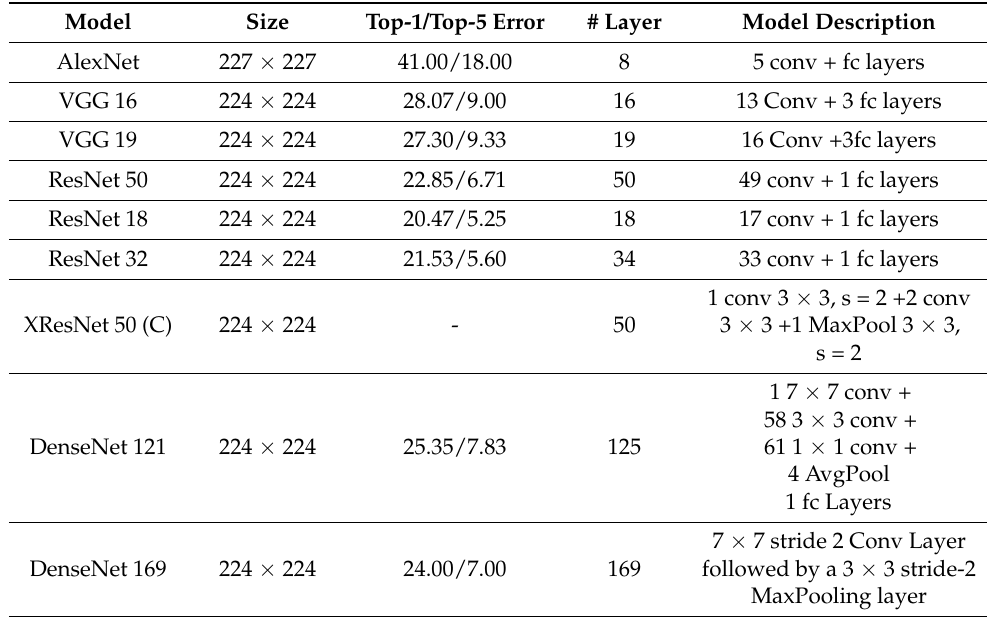
Table 1. Comparison of structure and input in different CNN learning